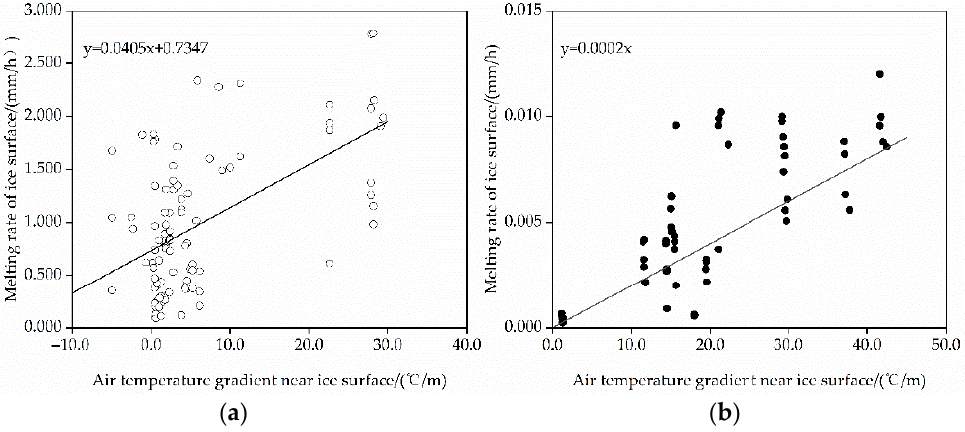
Figure 7. The statistical relationship between the surface melting rate and air temperature gradient.